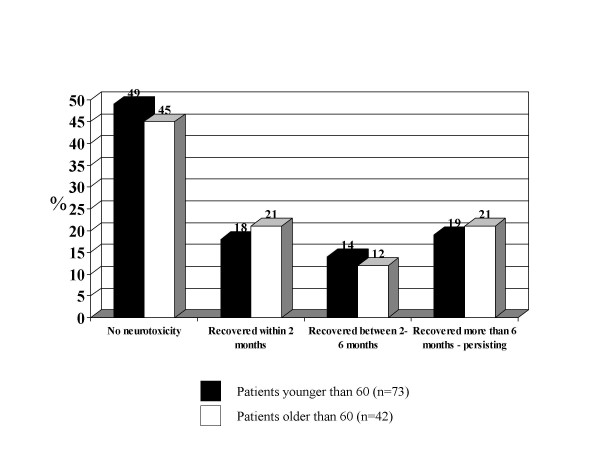
Duration of residual neuro-toxicity according to age category.